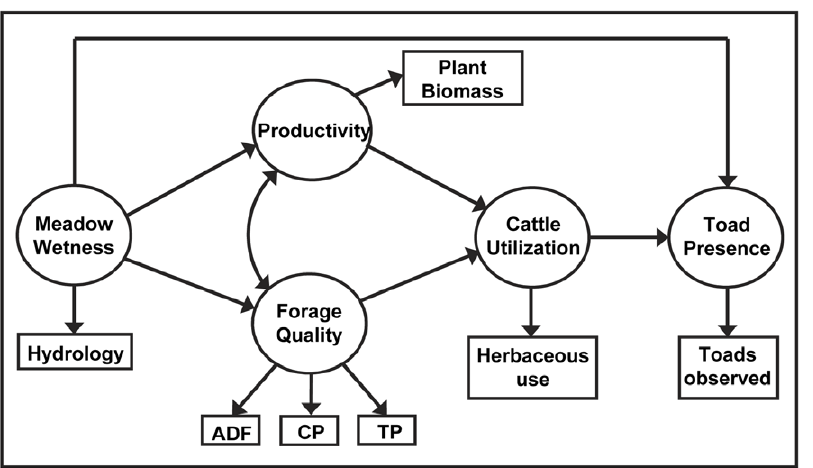
Figure 2. Conceptual Model. Conceptual model of the multiple hypothesized factors influencing toad meadow occupancy in the High Sierra Ranger District, Sierra National Forest, California, USA. Ovals indicate latent variables, which are estimated by observable indicators, represented by boxes. Straight arrows represent direct effects of one variable on another and curved arrows represent correlations between variables.